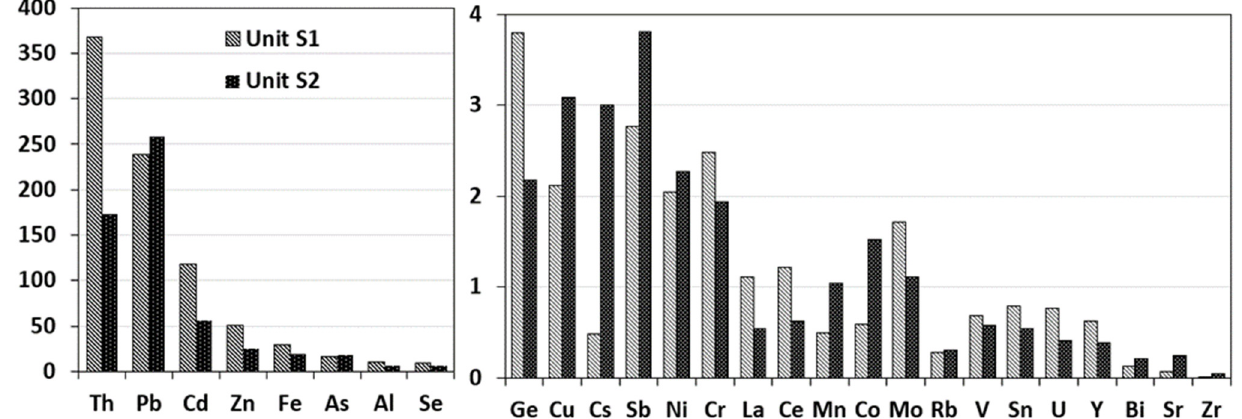
Figure 1. Contamination factor of metal(loid)s and REEs in the study area.